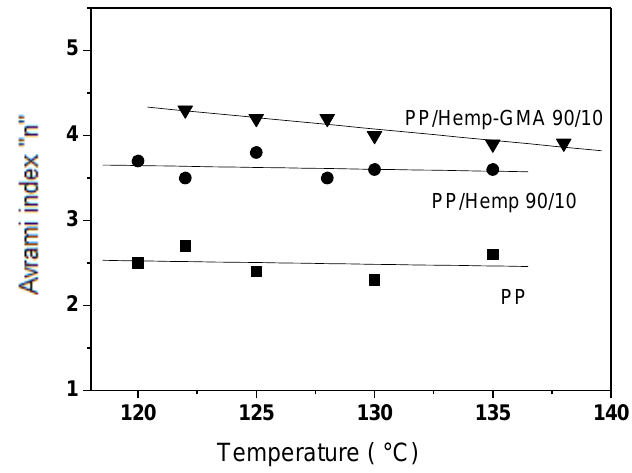
Figure 5. Values of the Avrami exponent n for PP/Hemp composites isothermally crystallized from melt at various